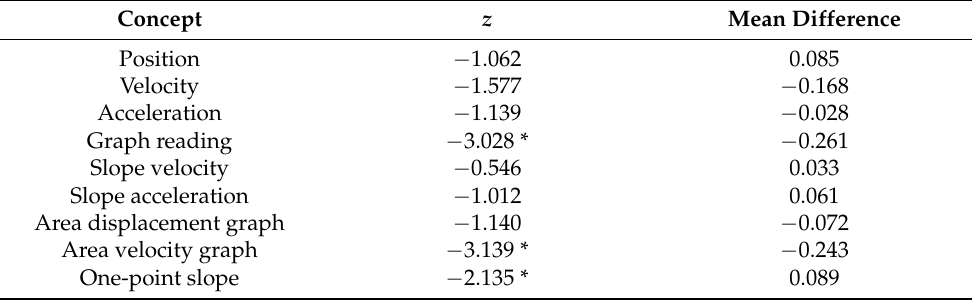
Table 4. The value of Mann–Whitney U-test for comparison differences in understanding physics concepts of Serbian and North Macedonian students in the TUG-K